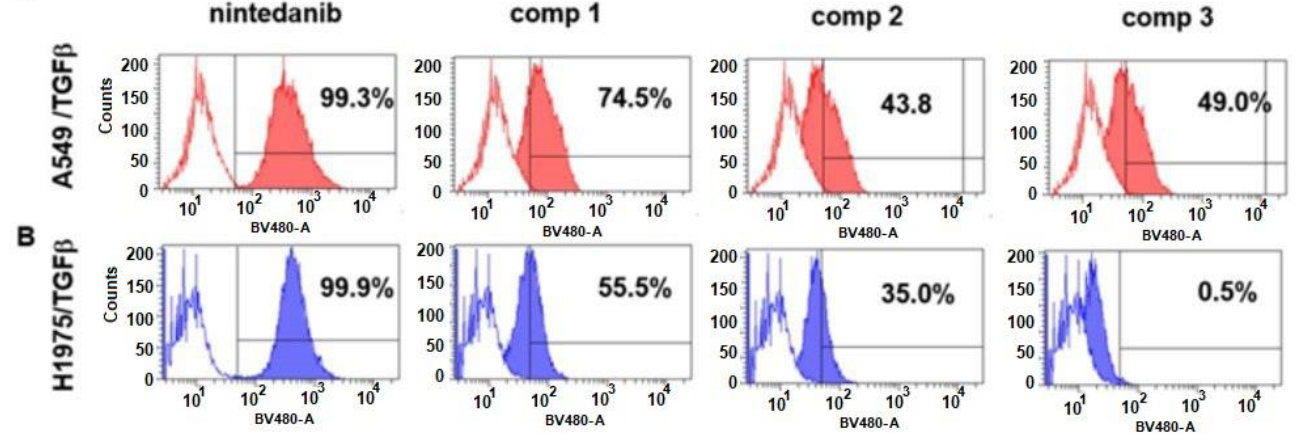
Figure 4. ( A ) Representative images of internalization of conjugates 1 – 3 or nintedanib as assessed by flow cytometry measurements. Fluorescence intensity (FacScan FLT1/BV405ex480em-A) in TGF 𝛽 -treated A549 cells ( A ) and TGF 𝛽 -treated H1975 cells ( B ) exposed for 24 h to nintedanib or conjugates 1 – 3 at 5 µM concentrations. Percentages indicate fluorescence (BV480-A)-positive cells from three independent experiments.